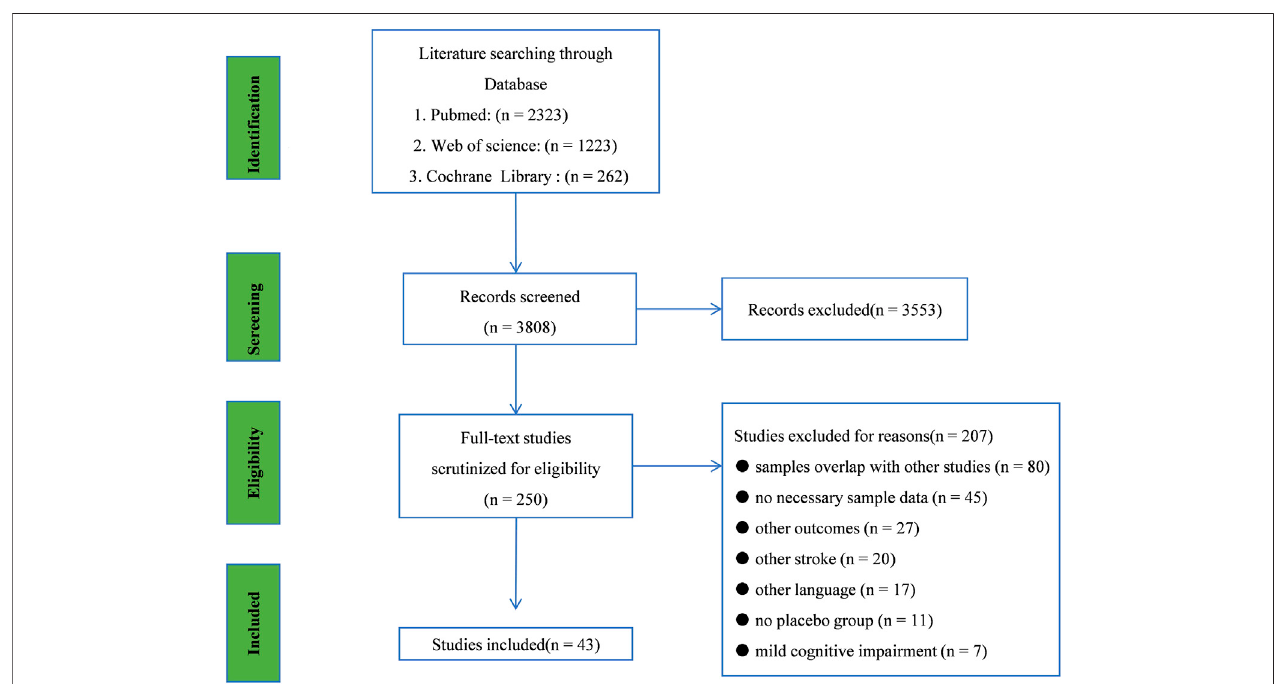
FIGURE 1 | Searching and screening process: literature search and study selection Through the initial search, we retrieved a total of 3,808 records from PubMed, Web of Science, and Cochrane Library. After examining the titles and abstracts, 250 studies were selected for further full-text scrutiny. In all, 207 studies were excluded duetothefollowingreasons:sampleoverlapwithotherstudies( n =80),nonecessarysampledata( n =45),otheroutcomes( n =27),otherstroke( n =20),otherlanguage ( n = 17), no placebo group ( n = 11), and mild cognitive impairment ( n = 7).